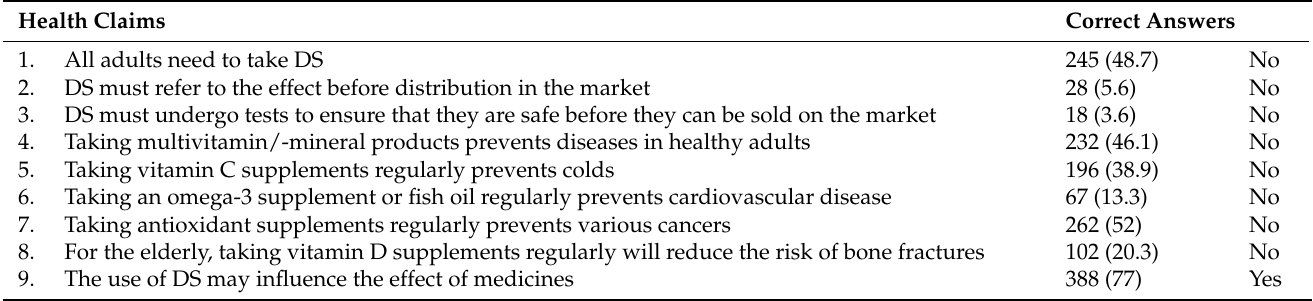
Table 4. Agreement or disagreement with nine health claims illustrated in frequency (n) and percent- age